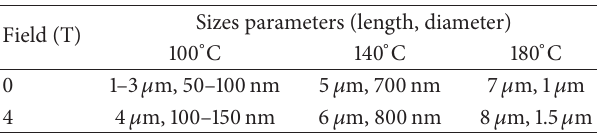
Table 1: Average size of the